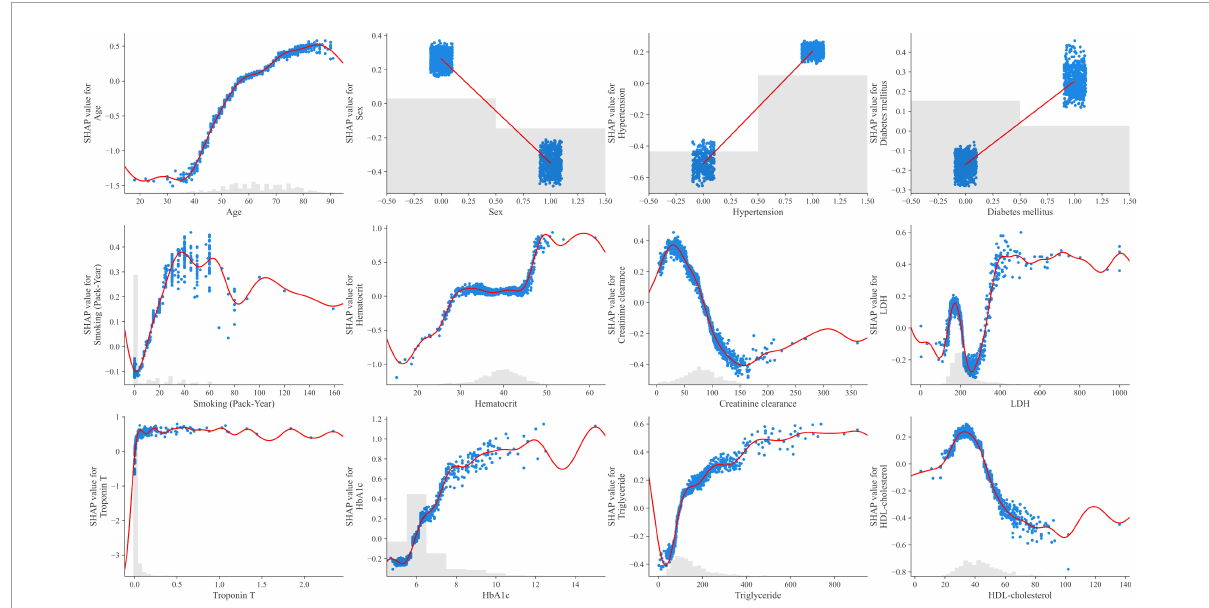
FIGURE4 SHAP dependence plots of the CatBoost model. HbA1c, hemoglobin A1c; HDL, high-density lipoprotein; LDH, lactate dehydrogenase; SHAP, SHapley Additive exPlanations; Troponin T, high-sensitivity cardiac troponin T.